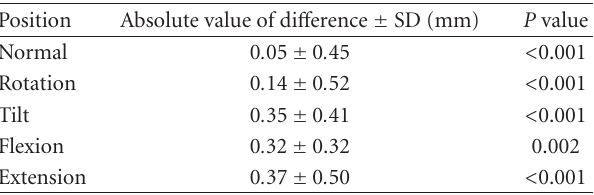
Table 5: Comparison of mean di ff erences with 0.5-mm absolute error: One-sample t